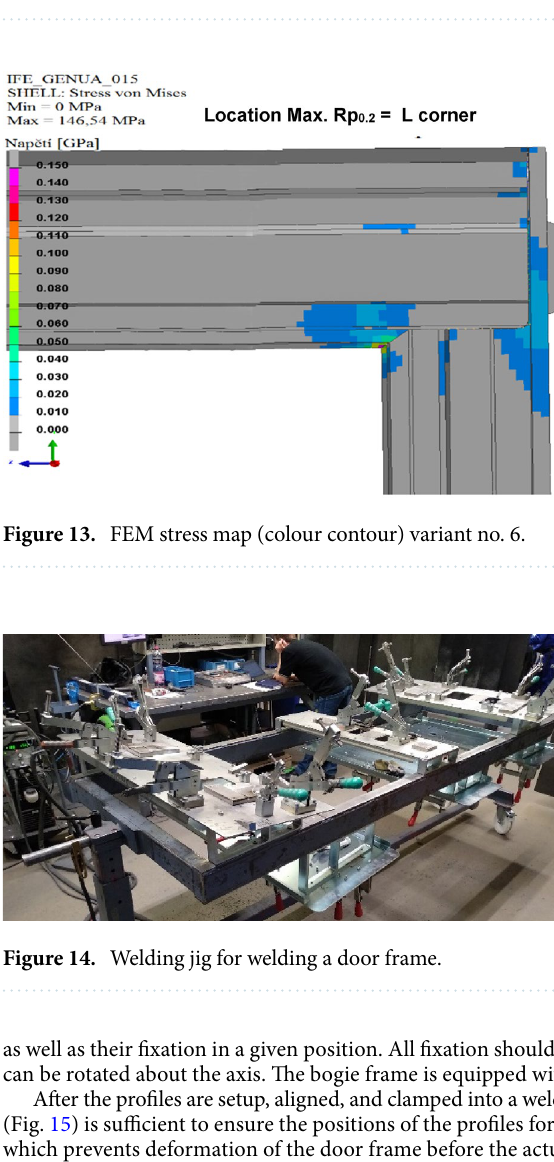
Figure 12. FEM stress map (colour contour) variant no. 5.